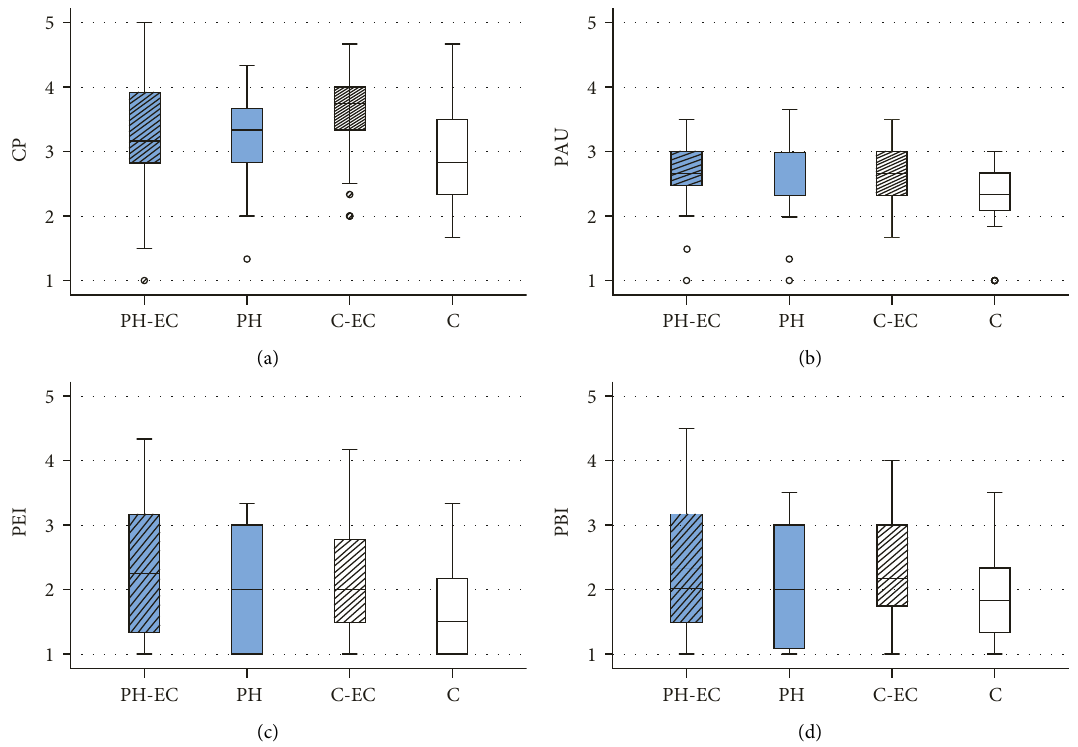
Figure 3: Social presence boxplots for the four conditions of the experiment: presumed human opponent with emotional communication (PH-EC), presumed human (PH), computer with emotional communication (C-EC), and computer (C). Blue boxes indicate presumed human conditions and hatched boxes indicate conditions with emotional communication. (a) Copresence (CP) mean scores, (b) perceived affective understanding (PAU) mean scores, (c) perceived emotional interdependence (PEI) mean scores, and (d) perceived behavioral interdependence (PBI) mean scores.